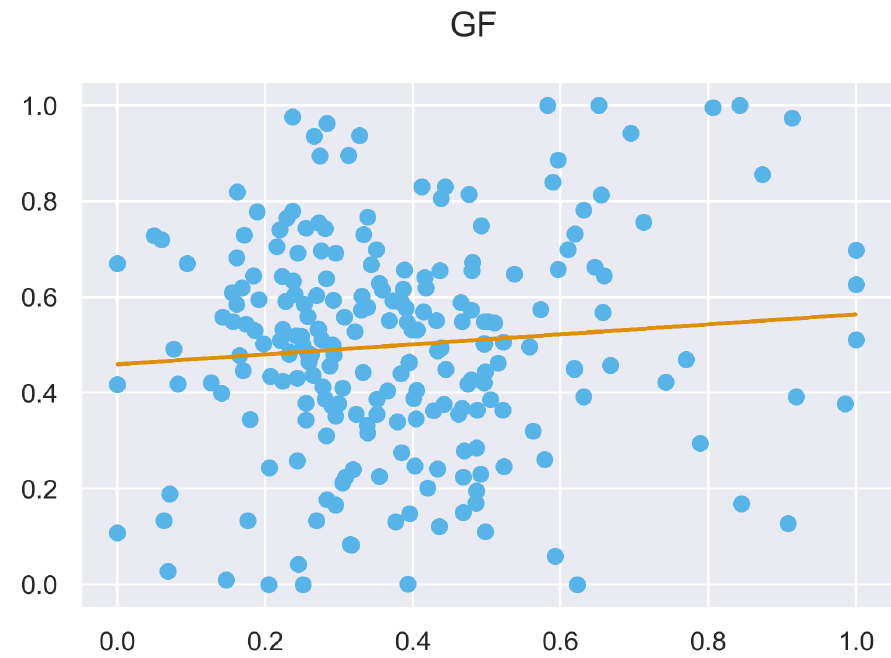
Figure A48. ULS and TLS GF regression at 5m grid